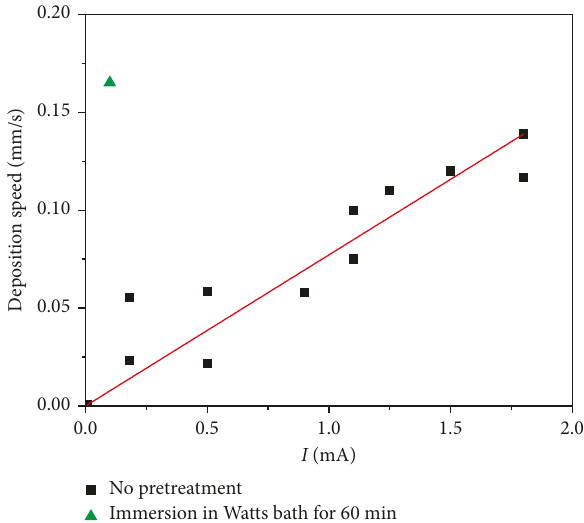
Figure 7: Copper coating rate on CNT fibers in copper sulfate electrolyte. Modified from [10] with additional